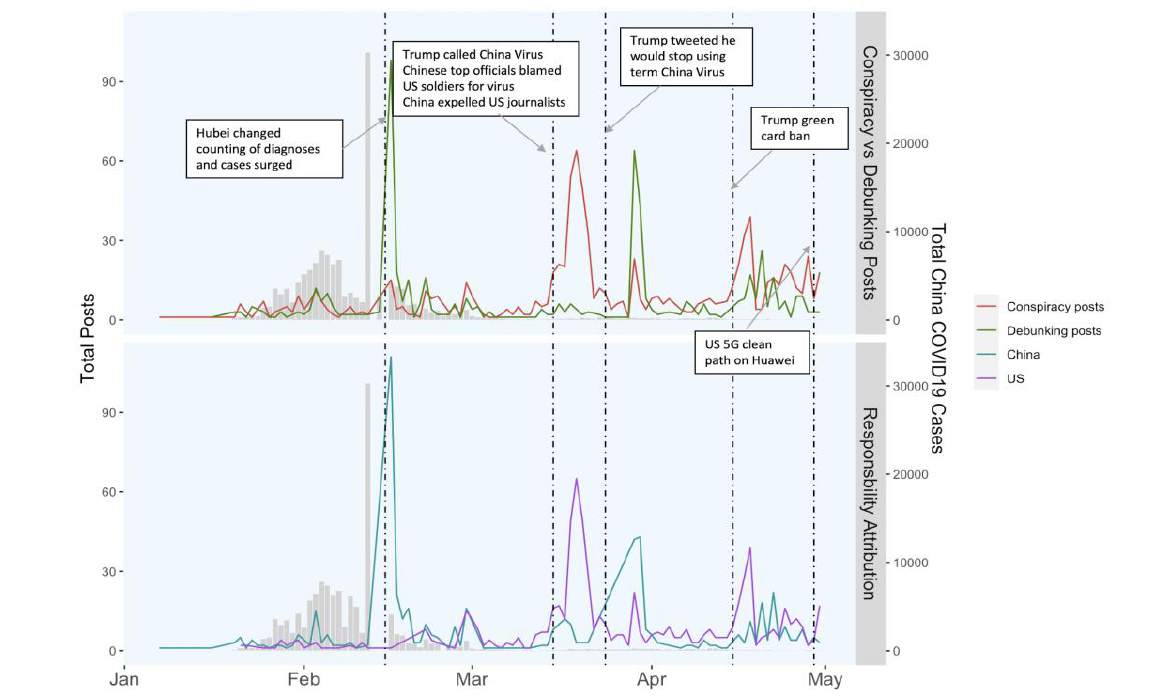
Figure 2. Evolution of conspiracy and debunking narratives and responsibility attribution